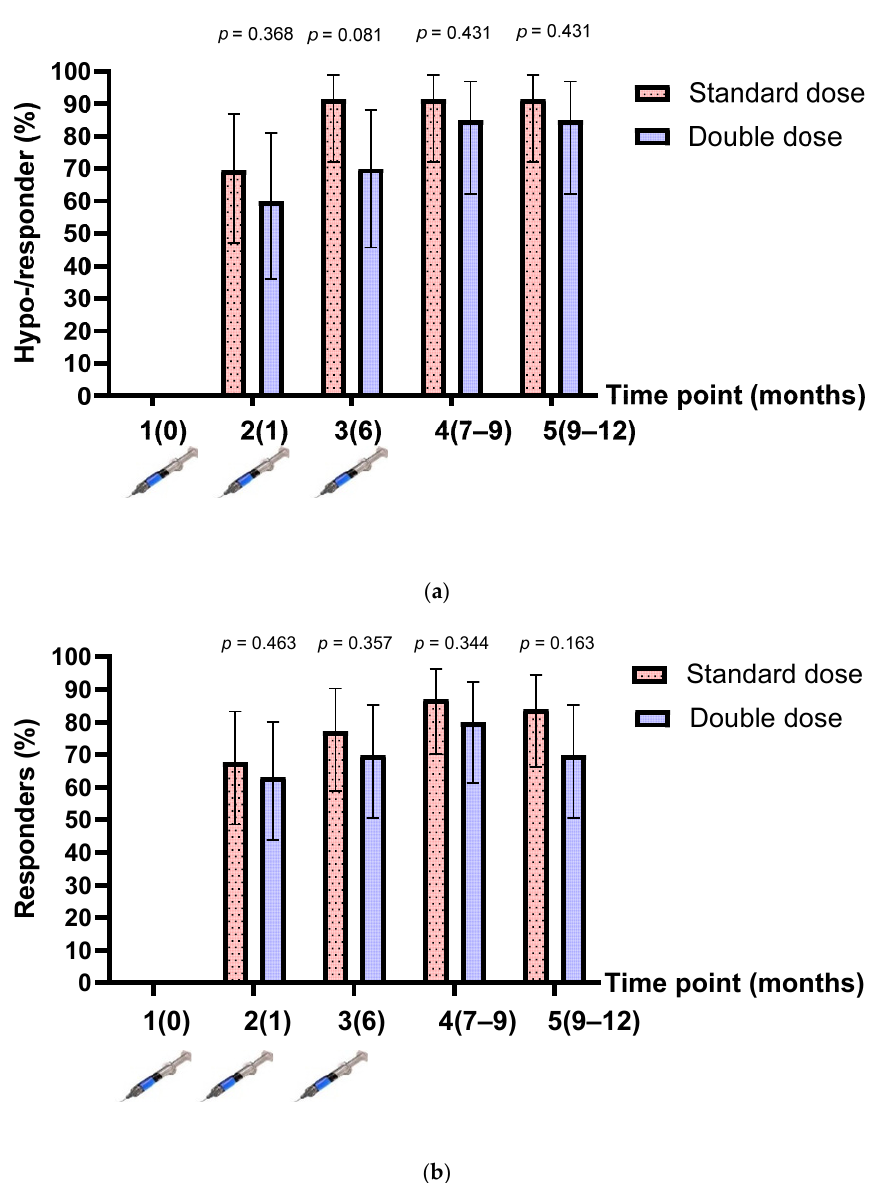
Figure 2. Anti-HBs response before and after 3-dose HepB vaccination. ( a ) Hyporesponders/responders from participants who had a baseline anti-HBs level of <10 mIU/mL (n = 43); ( b ) responders from participants who had a baseline anti-HBs level of <100 mIU/mL, before and after 3-dose HepB vaccination (n = 61). The GMT of anti-HBs was not significantly different between the SD and DD groups Table 2. Demonstration of the geometric mean titre (GMT) of anti-HBs levels before and after at five time points. The GMT of anti-HBs levels after the one-dose and three-dose vaccina- vaccination at five time points (per protocol population). tions were 151.93 (95% CI, 54.67–422.26) vs. 871.65 (95% CI, 358.42–2119.78) mIU/mL ( p = 0.032) in the SD group; and 163.75 (95%CI, 57.74–464.38) vs. 677.18 (95%CI, 251.80– 2401.82) mIU/mL ( p = 0.043) in the DD group (Table 2). After HepB revaccination, there Time from